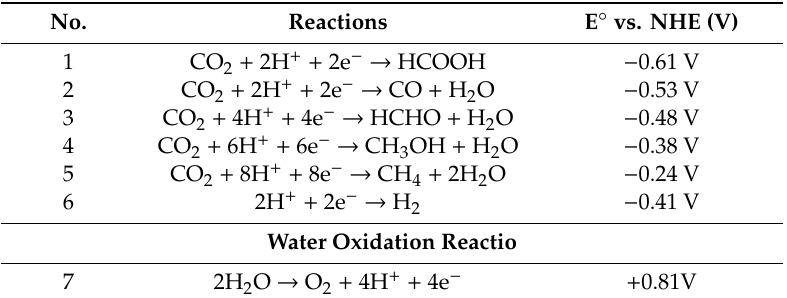
Table 1. Electrochemical redox potentials (E ◦ vs. NHE, pH = 7.0) for CO 2 reduction into a variety of useful chemical products